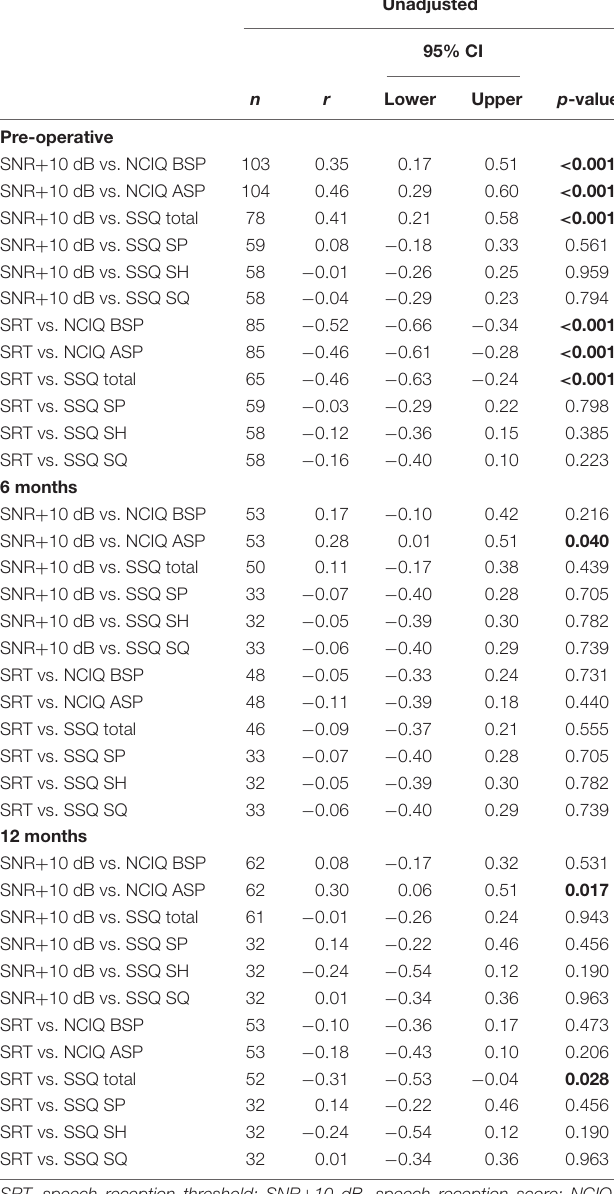
TABLE 5 | Unadjusted Pearson correlation for associations between SiN TABLE 4 | Pearson correlation for associations between the SSQ total score and perception ( + 10 dB SNR and SRTN) results and the NCIQ and SSQ among component tests of the NCIQ among all participants. all participants. Unadjusted model 95% CI n r Lower Upper